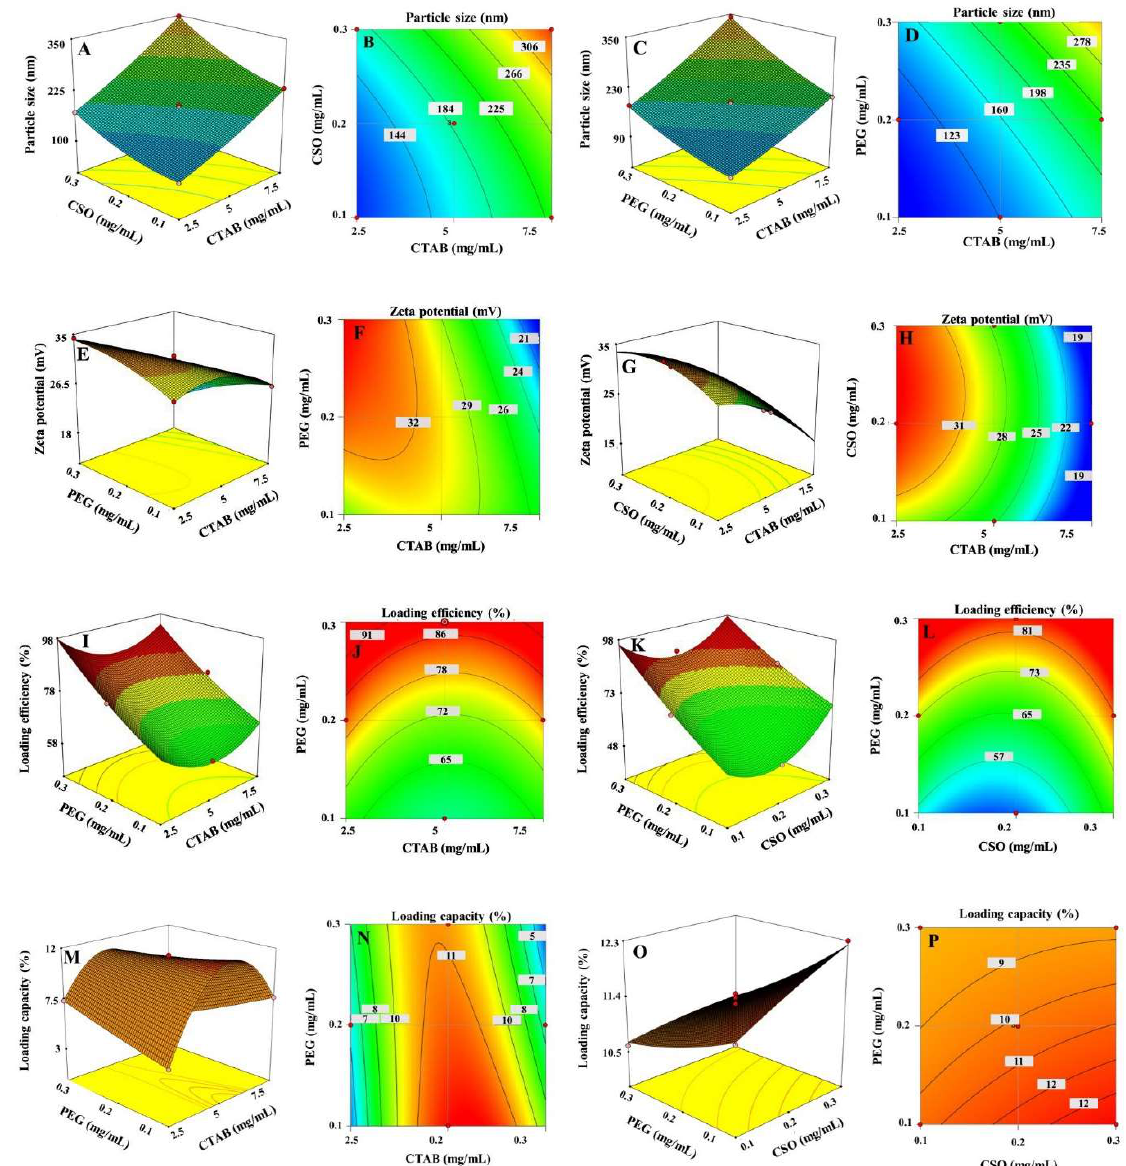
Figure 3. The 3D-RSPs and contour plots showing the effects of the CTAB (X 1 ), CSO (X 2 ), and PEG (X 3 ) concentrations on the responses of the ( A – D ) particle size (Y 1 ), ( E – H ) zeta potential (Y 2 ), ( I – L ) LE (Y 3 ), and ( M – P ) LC (Y 4 ).